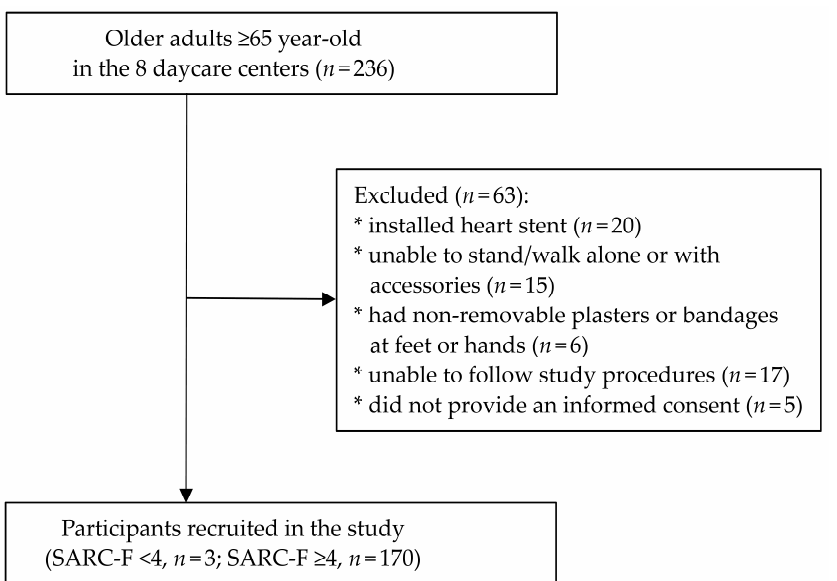
Figure 1. Flow chart of the selection of study participants.